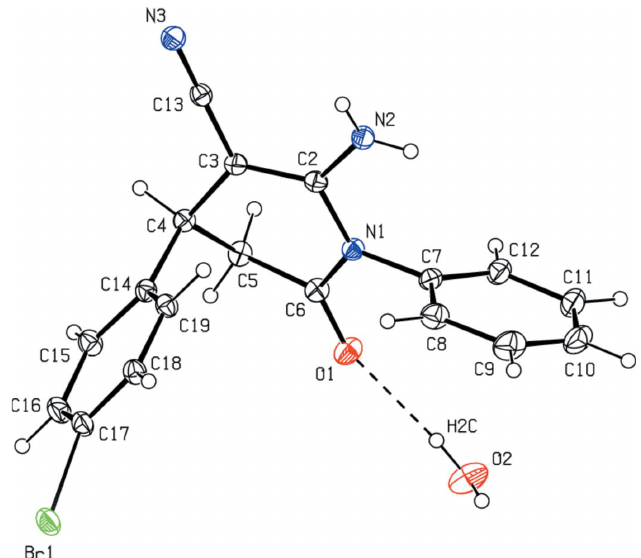
Figure 3 Overlay image of the two independent molecules (IIA and IIB) in the asymmetric unit of compound (II). Color code: carbon (gray), hydrogen (white), nitrogen (blue) and oxygen (red).